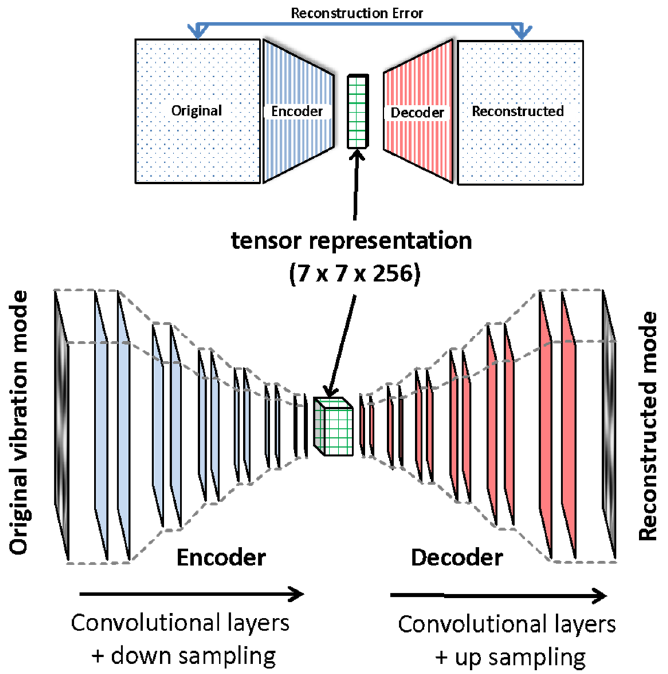
Figure 2. Detection of irregular patterns using convolutional auto-encoder .